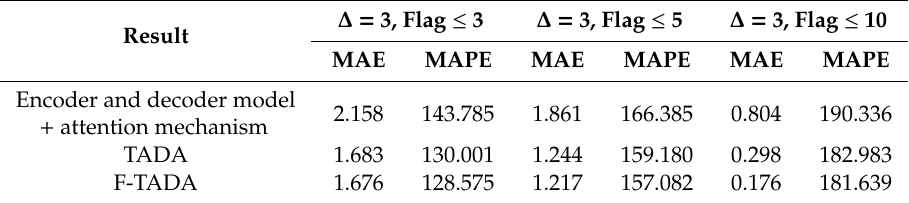
Table 3. Results for data set